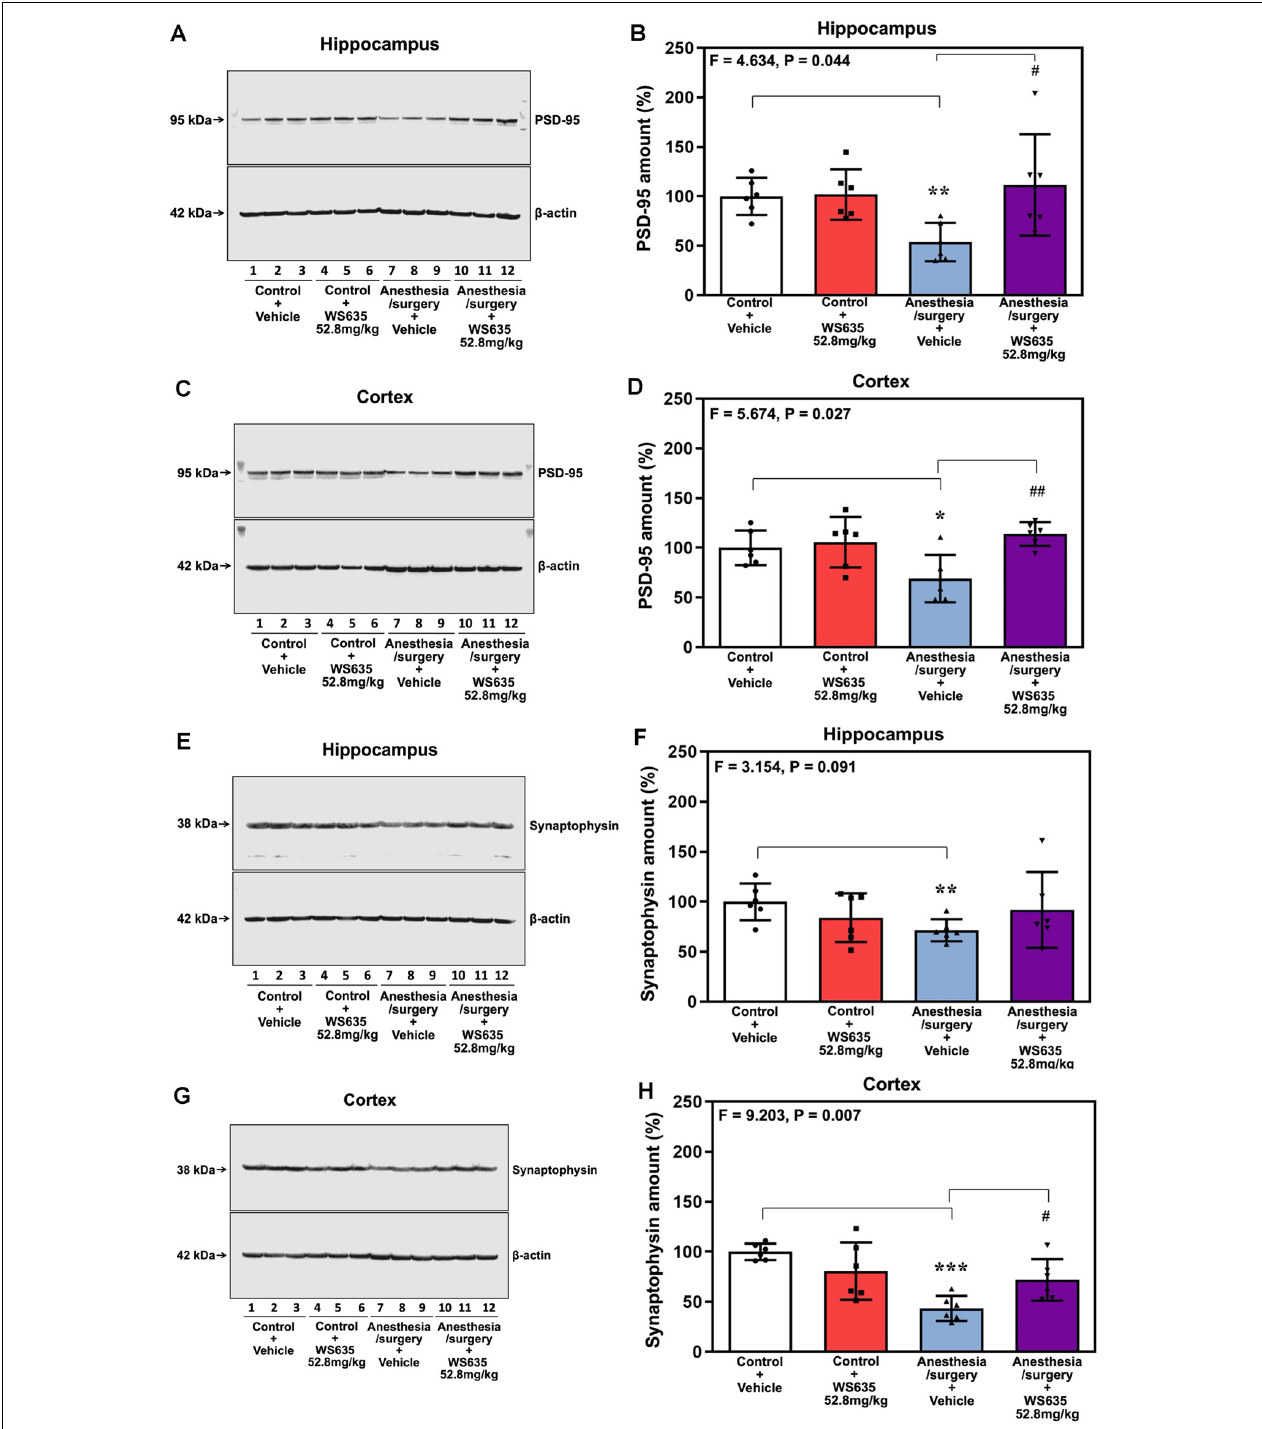
FIGURE 6 | Effects of WS635 on the anesthesia/surgery-induced changes in the amounts of postsynaptic density (PSD)-95 and synaptophysin in the hippocampus and cortex of mice. Effects of WS365 (52.8 mg/kg) and vehicle (DMSO) on the anesthesia/surgery-induced changes in the amounts of PSD-95 in the hippocampus (A,B) and cortex (C,D) of the mice on day 13 after the anesthesia/surgery. Effects of WS365 (52.8 mg/kg) and vehicle (DMSO) on the anesthesia/surgery-induced changes in the amounts of synaptophysin in the hippocampus (E,F) and cortex (G,H) of the mice on day 13 after the anesthesia/surgery. N = 6 mice in each group, * or # P < 0.05; ** or ## P < 0.01; *** P < 0.001. Two-way ANOVA with the post hoc test (Bonferroni correction) was used. P values refer to the difference among different conditions on the amounts of the PSD-95 and synaptophysin. DMSO, dimethyl